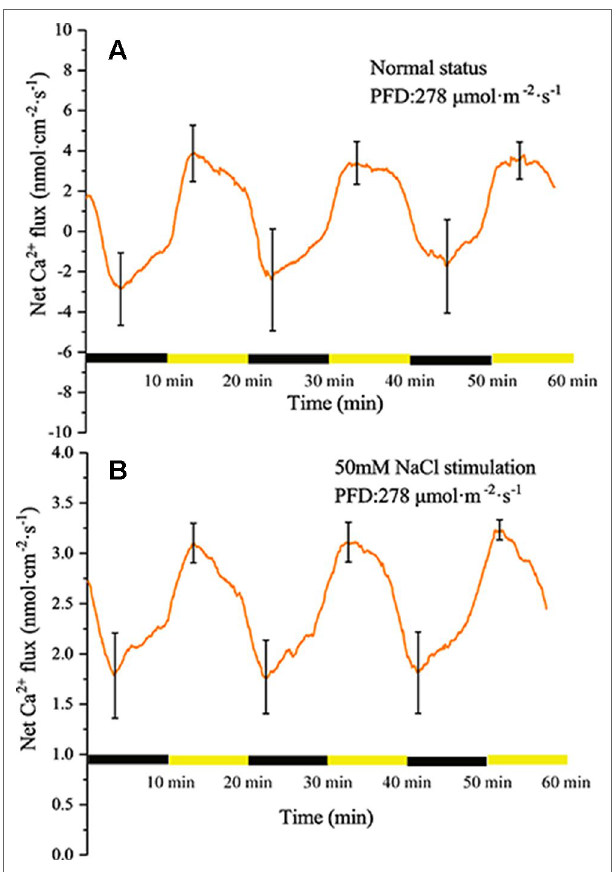
FIgURe 6 | Measurement of net Ca 2+ flux before and after 50 mM NaCl stimulation. (a) Net Ca 2+ flux induced by periodic illumination/darkness without NaCl treatment (normal condition). (B) Net Ca 2+ flux induced by periodic illumination/darkness with 50 mM NaCl stimulation. Note: wavelet decomposition was applied to the raw Ca 2+ flux data to remove noise using the Daubechies (db4) wavelet transform, where the wavelet layer number was 2–4. Mean ± SE ( n = 4); n—number of